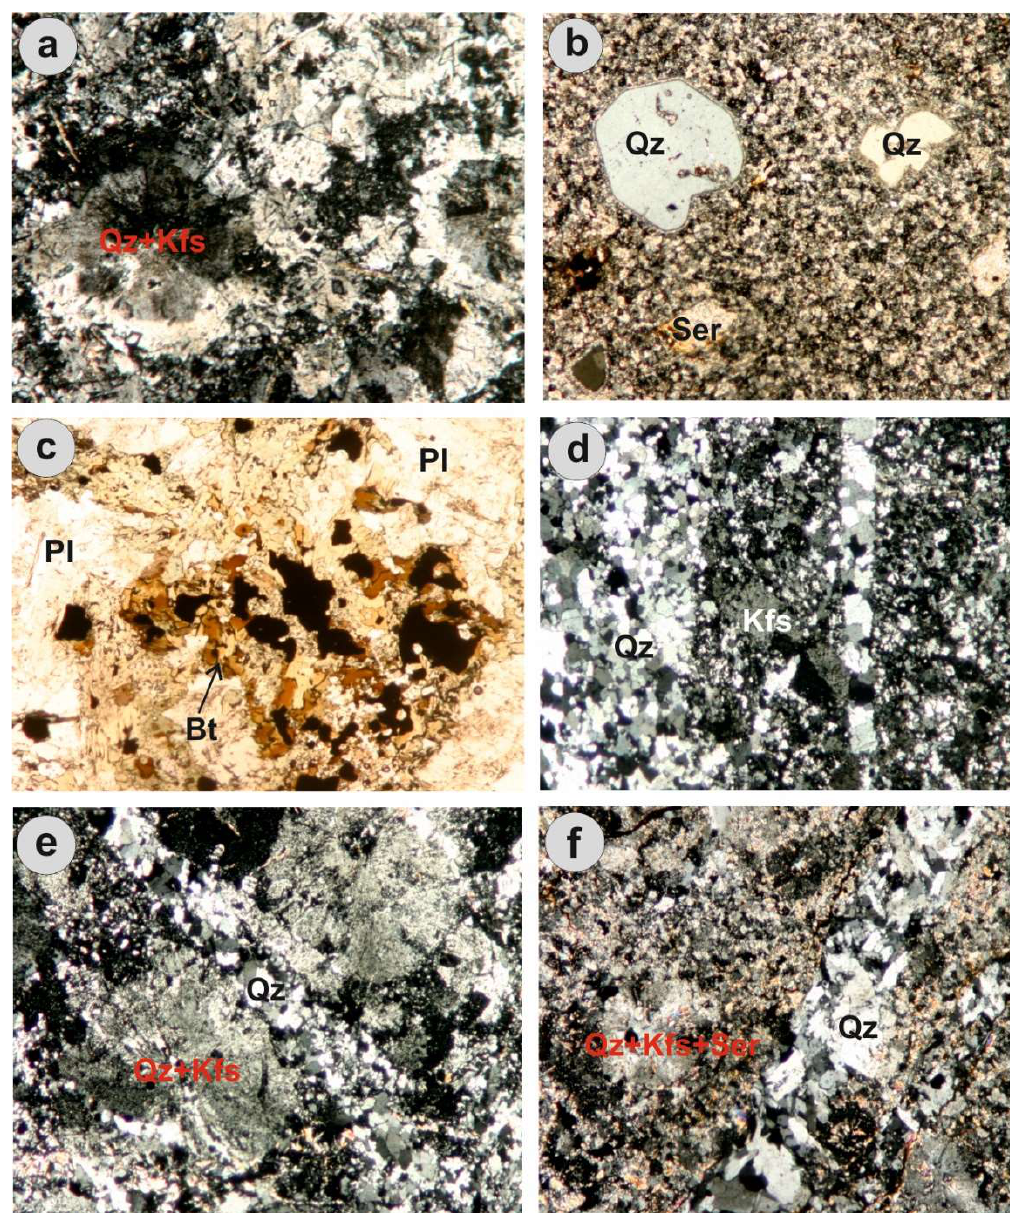
Figure 4. Microphotographs showing host rock lithologies and hydrothermal alteration at Aisymi-Leptokarya prospect. ( a ) Spherulitic quartz (Qz)-K-feldspar (Kfs) intergrowth in equigranular to porphyritic microgranite (crossed nicols, sample EG8); ( b ) Porphyritic microgranite composed of magmatic quartz (Qz) and sericitic (Ser) altered K-feldspar (Kfs) phenocrysts embedded in a quartz-sericite matrix (crossed nicols, sample EG21); ( c ) Selective potassic-sodic alteration of monzodiorite including hydrothermal biotite (Bt) and pyrite (black). Pl = plagioclase (plain polarized light, sample EG28); ( d ) porphyry-style quartz veinlets (Qz) related to potassic (Kfs) alteration (crossed nicols, sample EG6); ( e , f ) quartz (Qz)-K-feldspar (Kfs) spherulites crosscut by porphyry-style stockworks. Late sericite (Ser) is also present (crossed nicols, samples EG16 and EG15). Host rock in microphotographs ( d ) to ( f ) is microgranite. Length of the microphotographs = 2.6